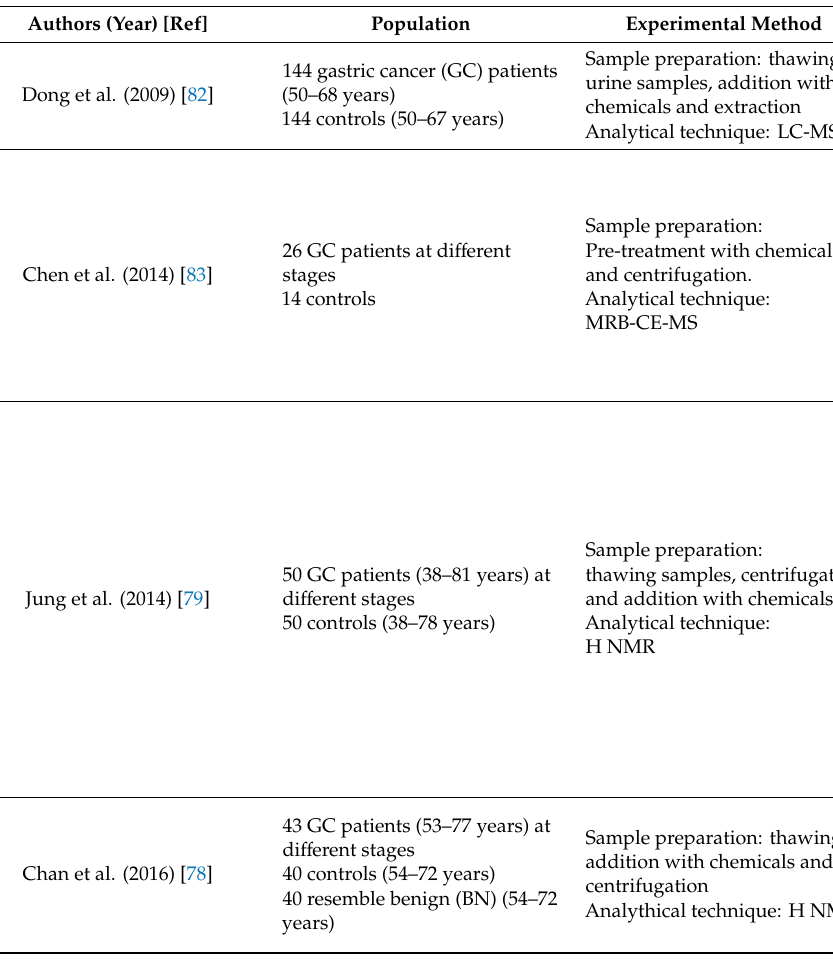
Table 5. Literary studies investigating urinary biomarkers for stomach